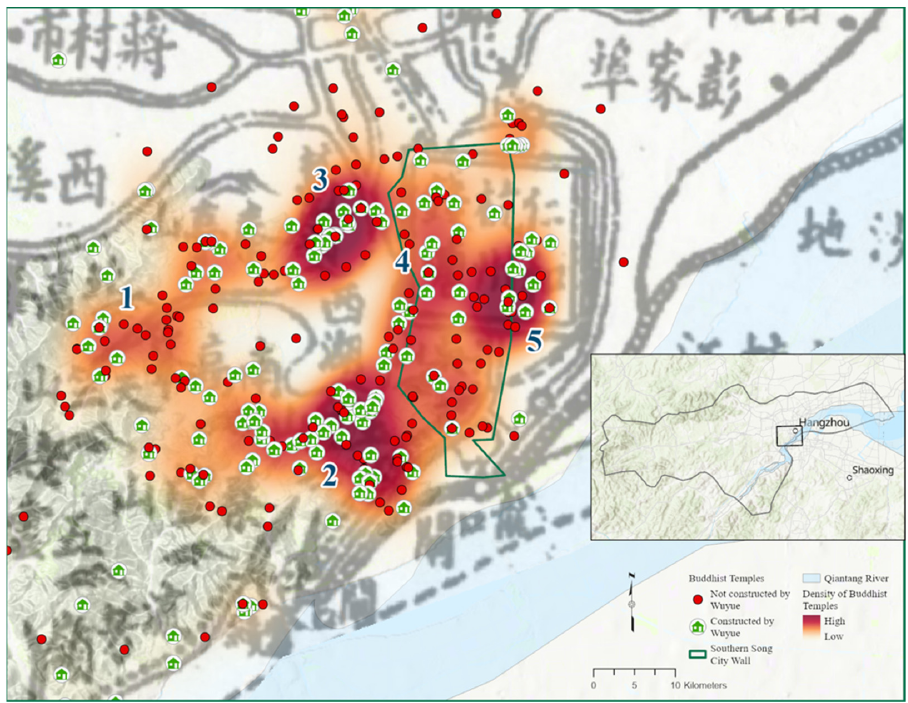
Figure 5. Distribution of Buddhist temples constructed by the Wuyue 吳越 kingdom overlapped with the hot zones (from the result of kernel density analysis).